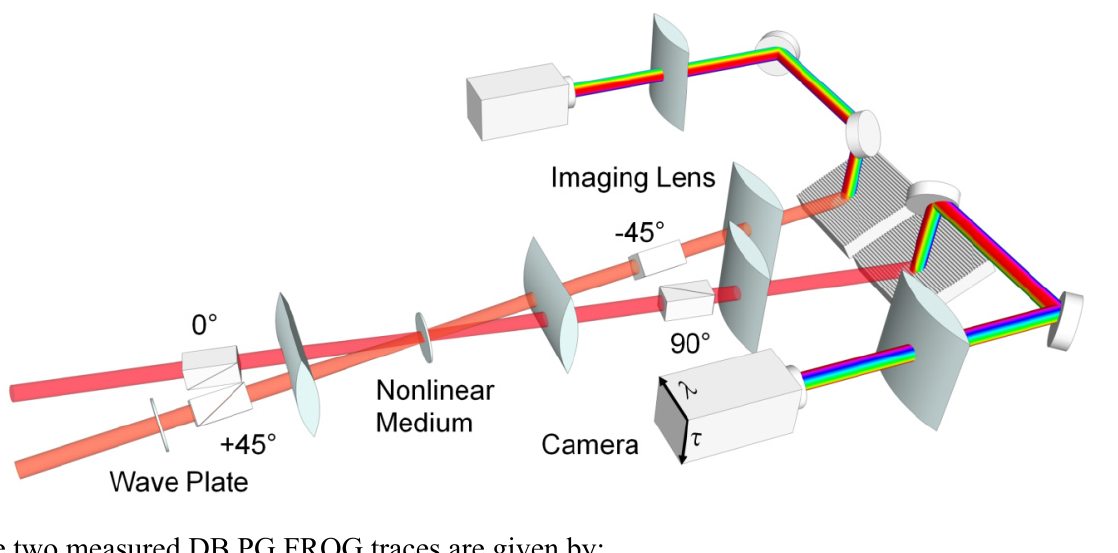
Figure 9. The schematic of single-shot Double Blind (DB) PG FROG for measuring an unknown pulse pair